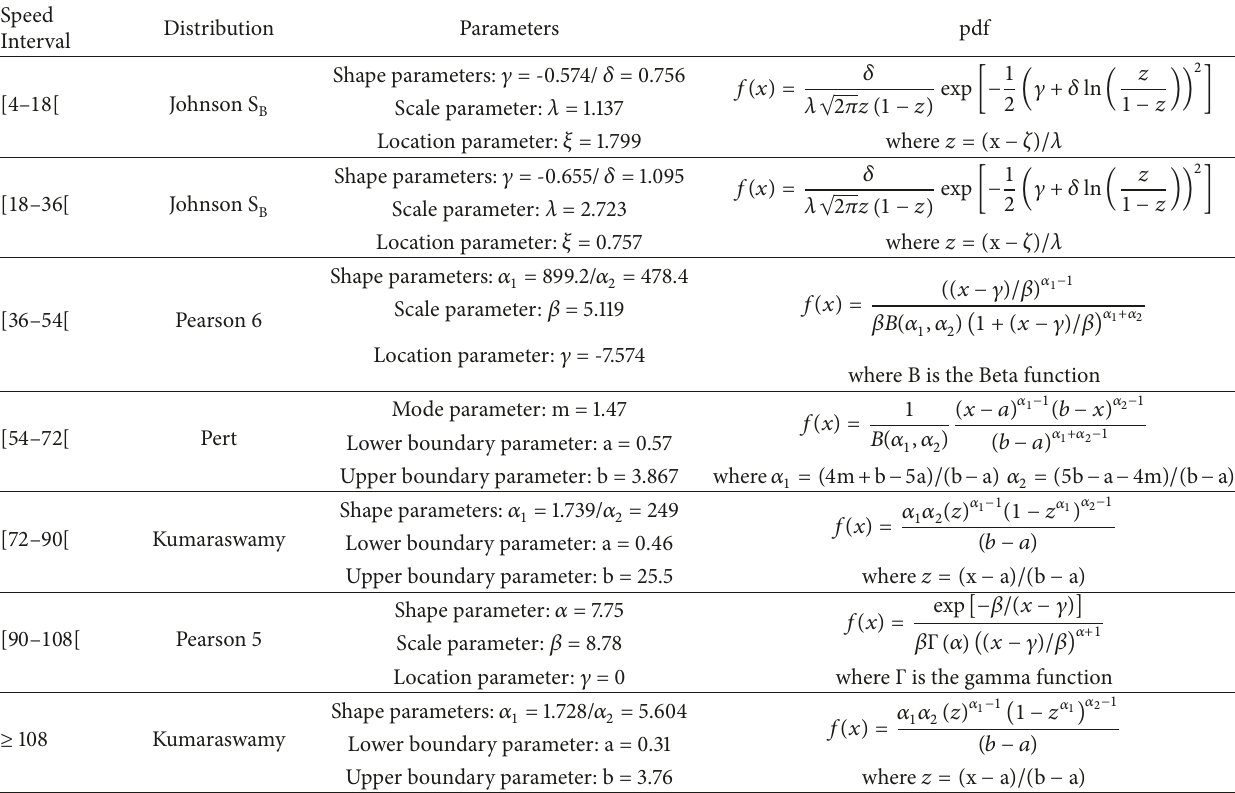
Table 4: Best statistical distributions for all drivers and all speed intervals according to the K-S goodness-of-fit method. Speed Distribution Interval